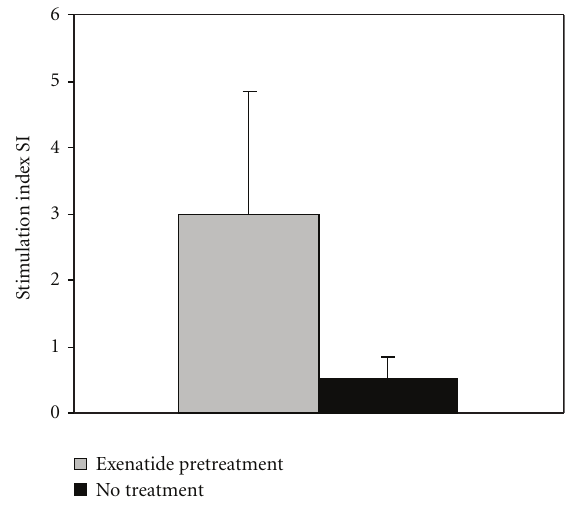
Figure 6: In vitro static glucose stimulation assays performed on freshly isolated islets showed a significant improvement in stimula- tion index of insulin release for islets that had been pre-treated with exenatide in vivo compared to untreated islets. ∗ P ≤ 0 .